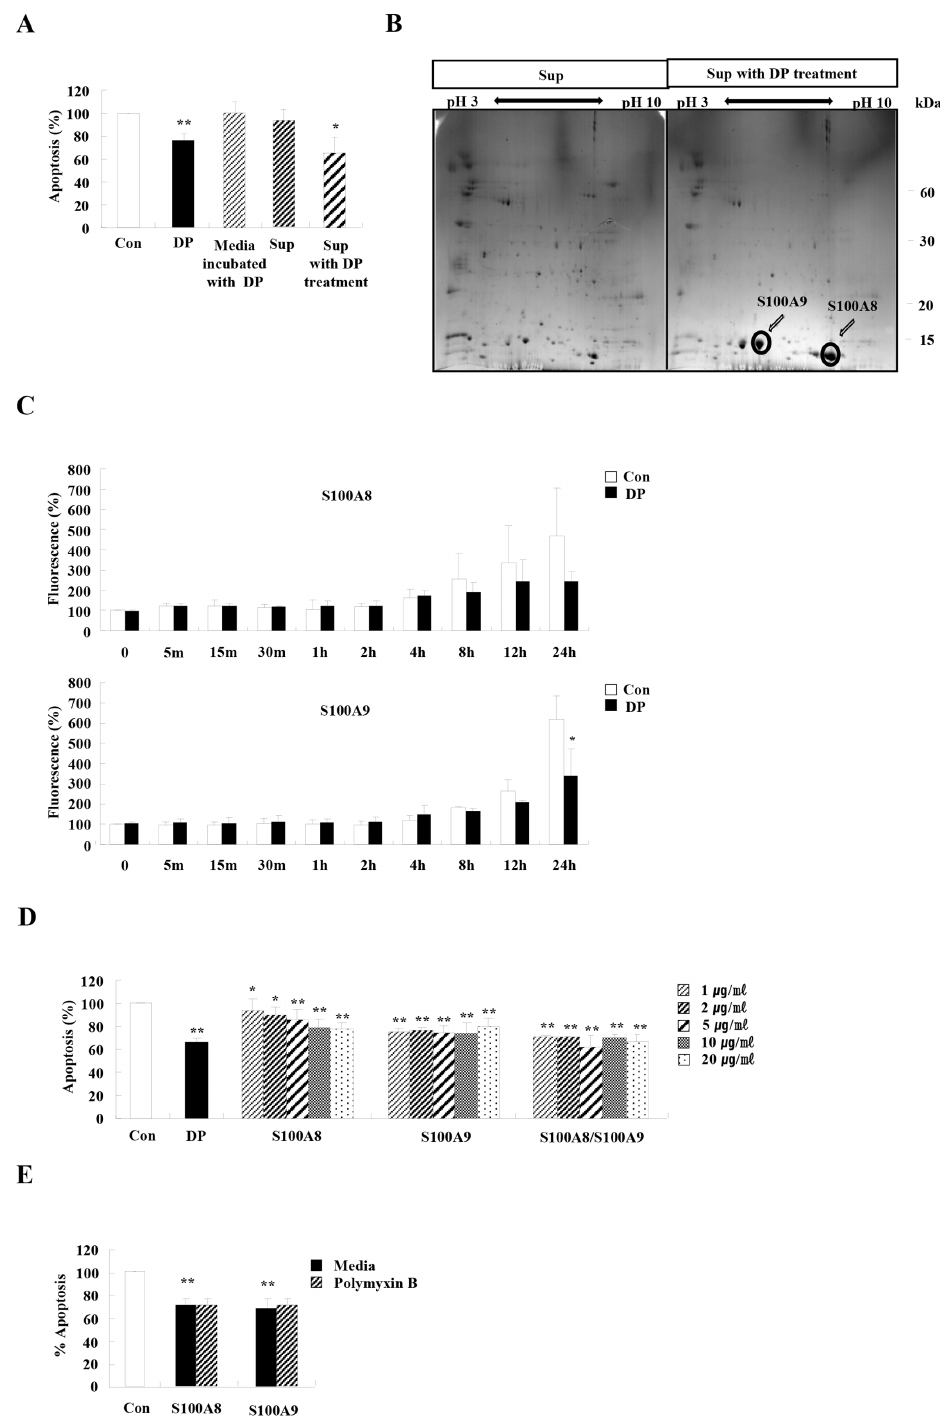
Fig 3. Both S100A8 and S100A9 are released after DP treatment and suppress neutrophil apoptosis. (A) Neutrophils were incubated with and without 10 μ g/ml of DP for 24 h. The supernatant (Sup) was collected and added to the fresh neutrophils obtained from the peripheral blood of normal individuals (n = 9). Media were incubated with DP for 24 h in a 5% CO 2 incubator at 37°C. The media were collected and added to the fresh neutrophils obtained from the peripheral blood of normal individuals (n = 5). Apoptosis was analyzed by measuring the binding of annexin V-FITC and PI. Data are expressed as the means ± SD and are presented relative to the control, which was set at 100%. ** p < 0.01 indicates a significant